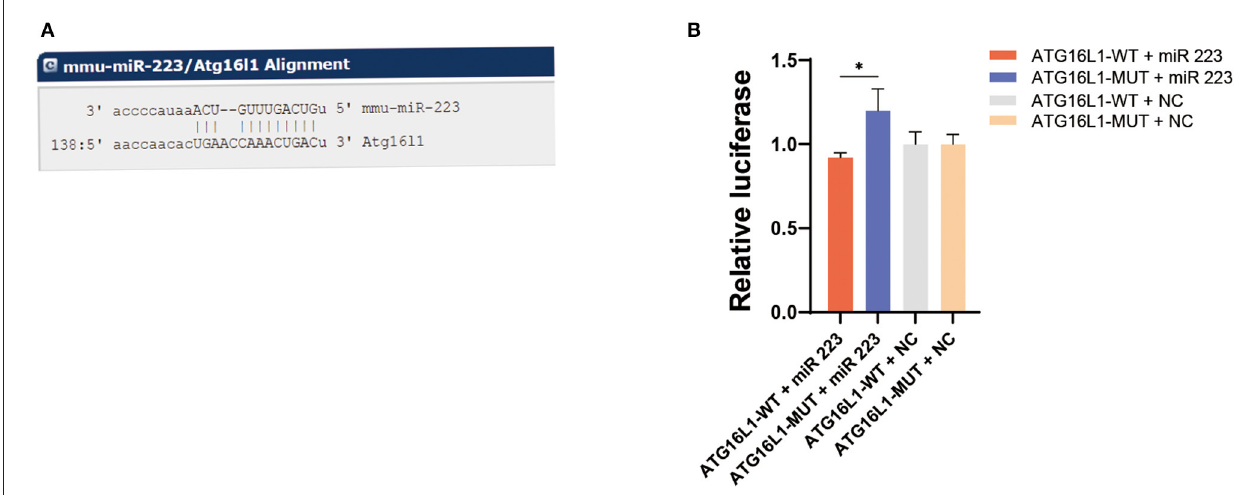
FIGURE 4 | ATG16L1 gene is a direct target of miR 223. (A) The site for miR 223 binding to ATG16L1 was predicted by (http://www.microRNA.org) (http://www. microrna.org/microrna/home.do). (B) miR-223 regulates ATG16L1 expression, as shown by the dual-luciferase reporter assay in 293T cells. Statistically significant differences were determined using the unpaired t -test. Data are presented as means ± SD ; * p < 0.05 ( n = 3 per group). miR, microRNA; SD , standard